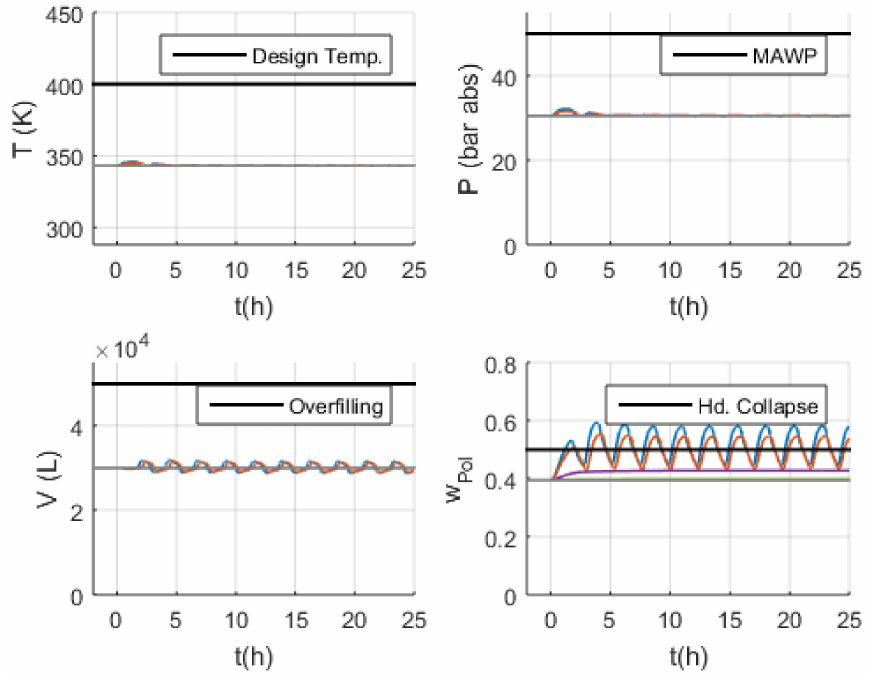
Figure 23. Behavior of critical variables in scenario S-18 with Model 1. Inlet catalyst flowrate: (